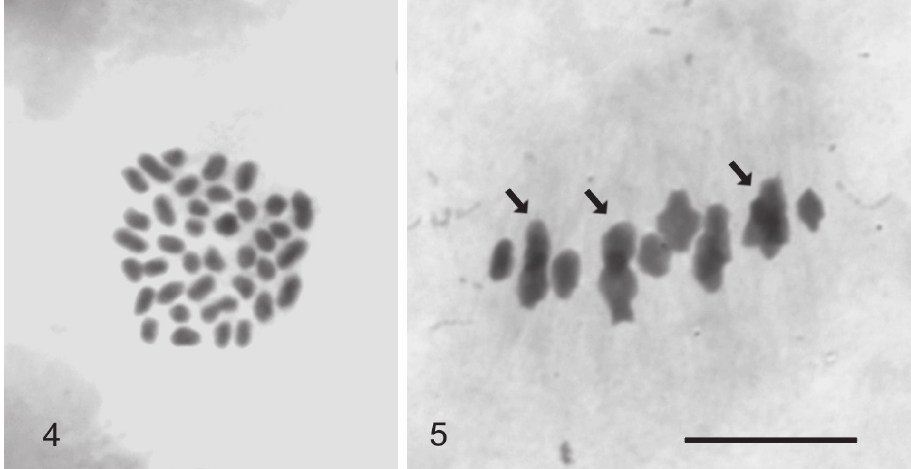
Figures 4–5. Female meiosis in C. ledi . 4 Metaphase from mature egg with 39 univalent chromosomes 5 Metaphase I plate with 13 chiasmate bivalents (12 + XX), sex chromosome bivalent cannot be identi- fied. Arrows point to three overlapping pairs of bivalents. Scale bar: 10 Table 2. Number of triploid and diploid females in Turku population.